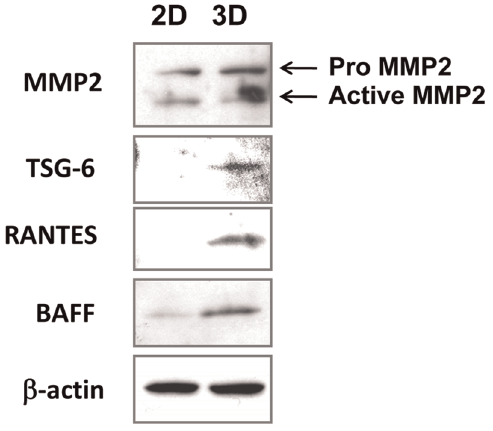
Figure 4. Western blot validation. Total protein (50 m g) prepared from NCI-H226 spheroids (3D) and monolayer (2D) cells were loaded to SDS-PAGE followed by Western blot analysis.